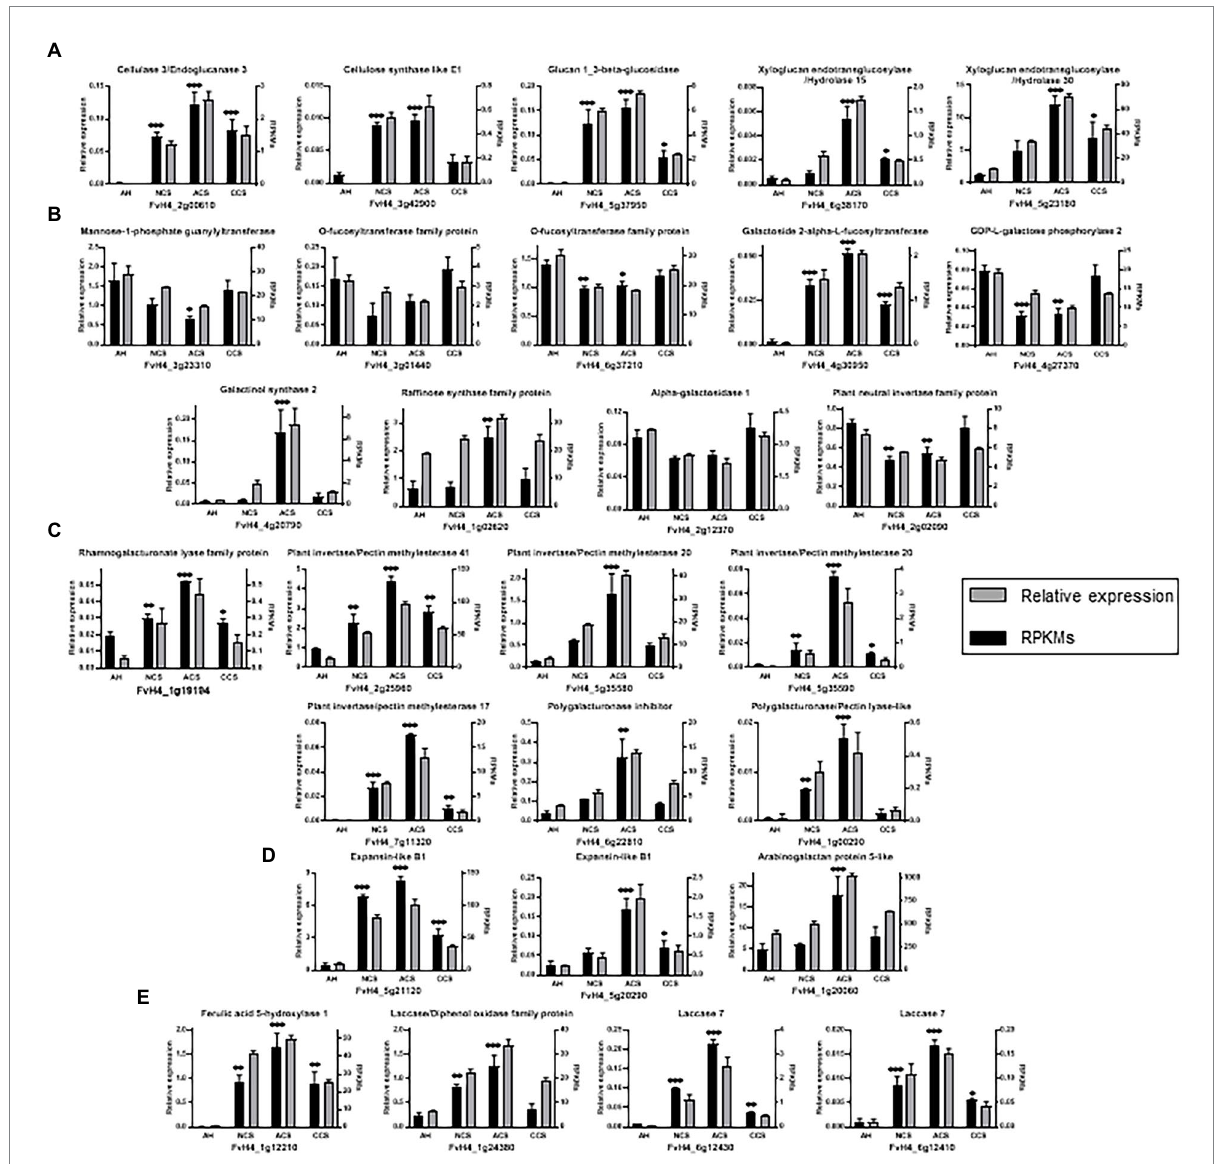
FIGURE 11 Expression analysis of a group of 28 genes co-expressed by Weighted Gene Correlation Network Analysis. Relative expression analysis through qPCR (black bars) vs. RPKMs obtained in RNAseq (gray bars) for genes involving: (A) metabolism of cellulose and hemicellulose, (B) N-glycosylation processes and cell wall simple sugars and polysaccharides metabolism, (C) pectins metabolism, (D) cell expansion and plant growth (E) and lignin metabolism. Graphs represent the average of at least three independent replicates quantified. Error bars indicate ± SD; One-way ANOVA for relative expression of AH versus NCS, ACS, or CCS value. Adjusted p value (* p ≤ 0.03, ** p ≤ 0.002; *** p <